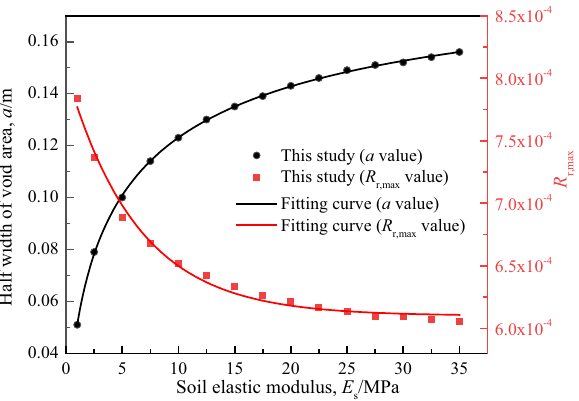
Figure 16. Relative detachment extent between pipeline and soil under different soil elastic modulus.